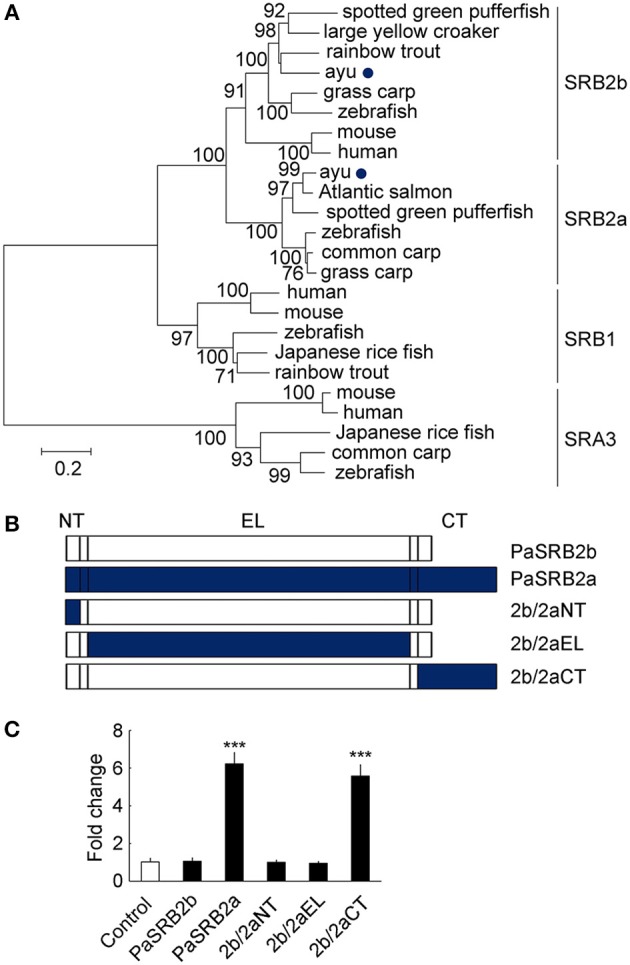
The critical domains for PaSRB2a uptake of LPS. (A) Phylogenetic (neighbor-joining) analysis of SRB amino acid sequences using MEGA 5.0. Node values represent the percentage bootstrap confidence derived from 1,000 replicates. The accession numbers of scavenger receptor genes are listed in Table 3. (B) Organization of cDNAs encoding PaSRB2a and PaSRB2b chimeras. PaSRB2a and PaSRB2b are predicted to have an intracellular N terminus, large extracellular domain, and intracellular C terminus. (C) LPS internalization in HEK293T cells transfected with PaSRB2a-PaSRB2b chimeras. 2b/2aNT: PaSRB2b-PaSRB2a N-terminal domain chimera, 2b/2aEL: PaSRB2b-PaSRB2a extracellular loop domain chimera, 2b/2aCT: PaSRB2b-PaSRB2a C-terminal chimera. Data are expressed as fold-change compared to the control. ***P < 0.001.